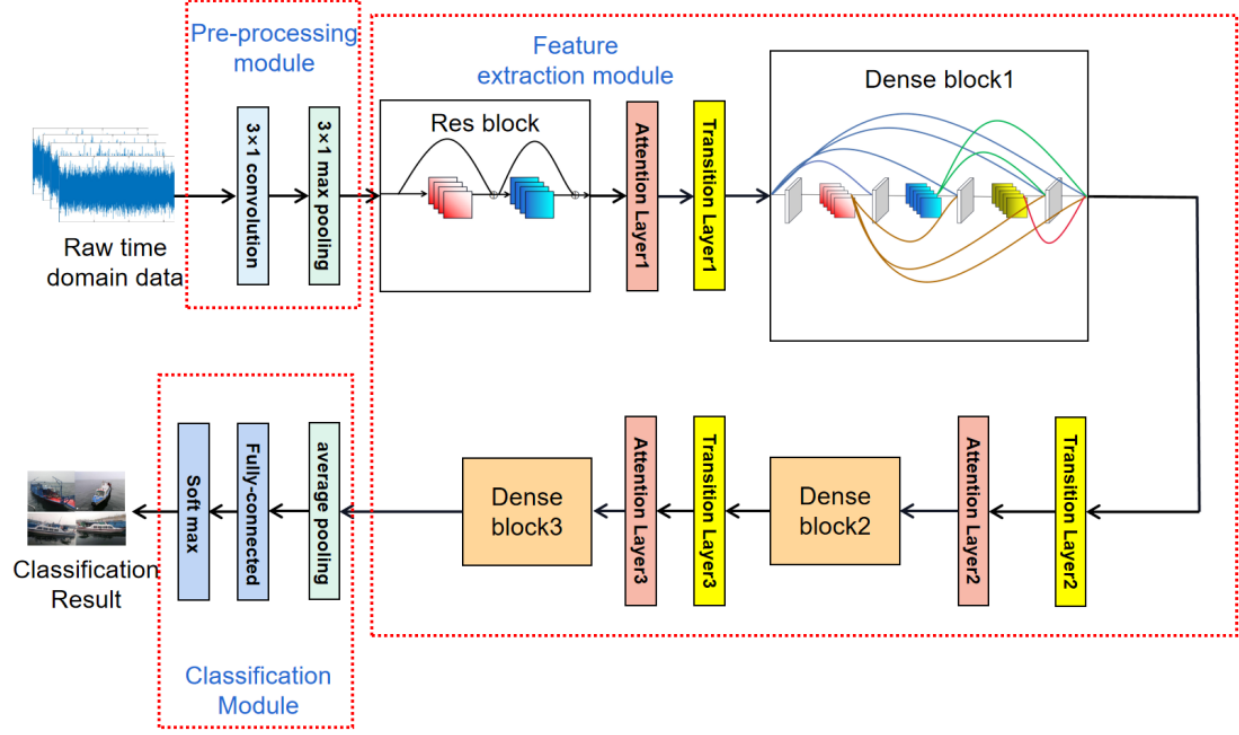
Figure 4. Schematic diagram of the proposed CTA-RDNet. Table 1. Parameter settings for each layer of the CTA-RDNet. Layer Parameters of Each Layer pre-processing layer